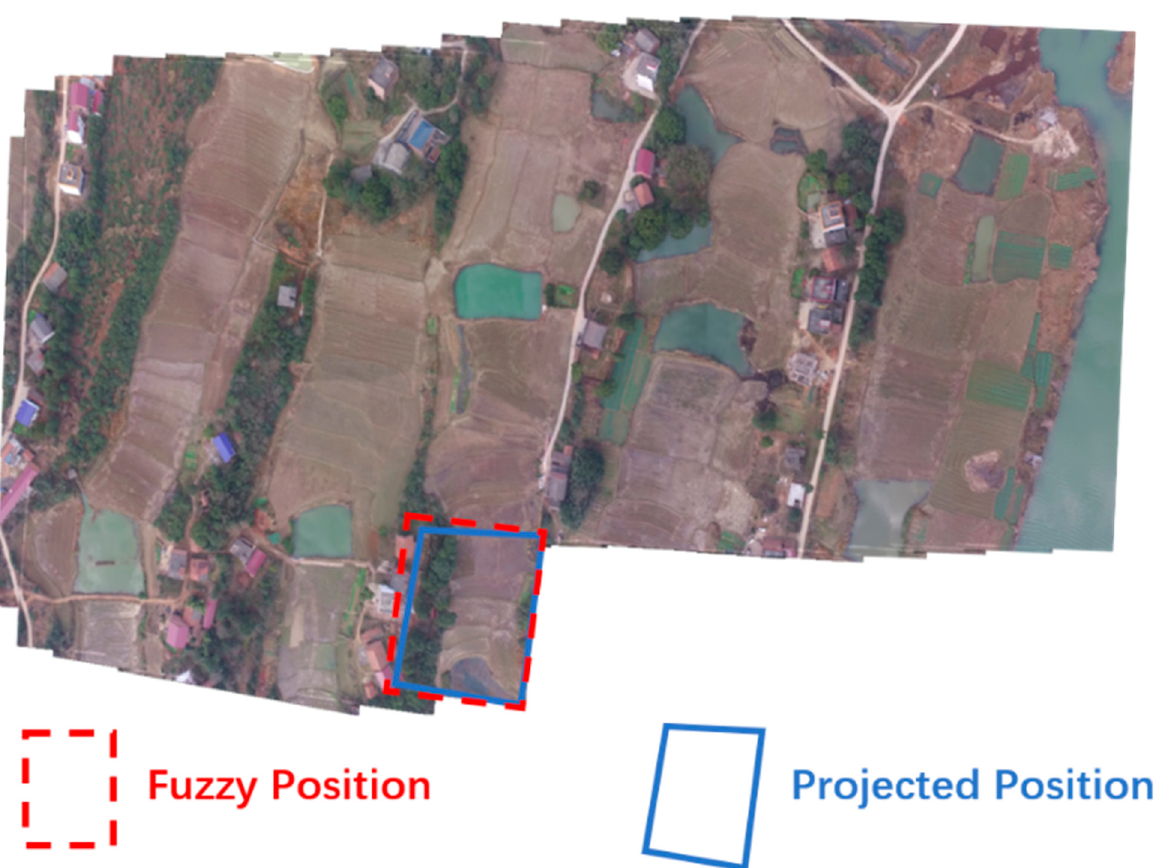
Figure 2. Fuzzy location. Red dashed box represents fuzzy position and blue box represents projected position. Fuzzy position is the minimum bounding rectangle of projected position.